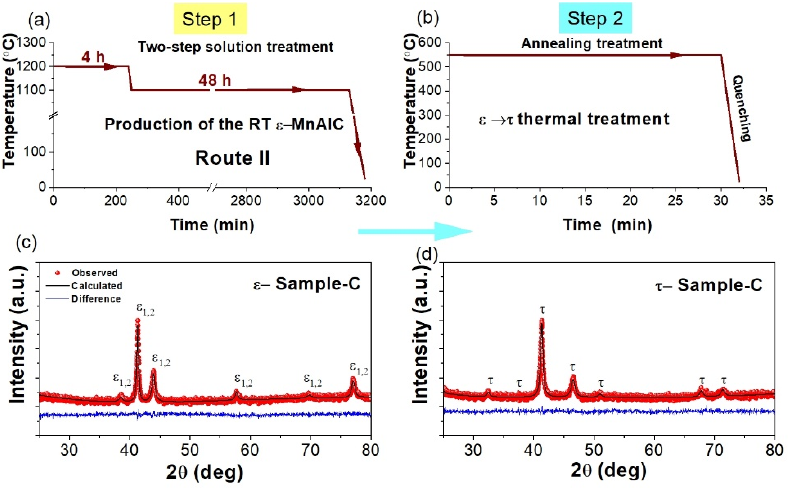
Figure 3. Schematic representation of the thermal treatments (Route II) followed to produce τ -phase from ( a ) step 1 and ( b ) step 2. ( c , d ) are XRD patterns taken in the resulting sample from ( a , b ), re- spectively.